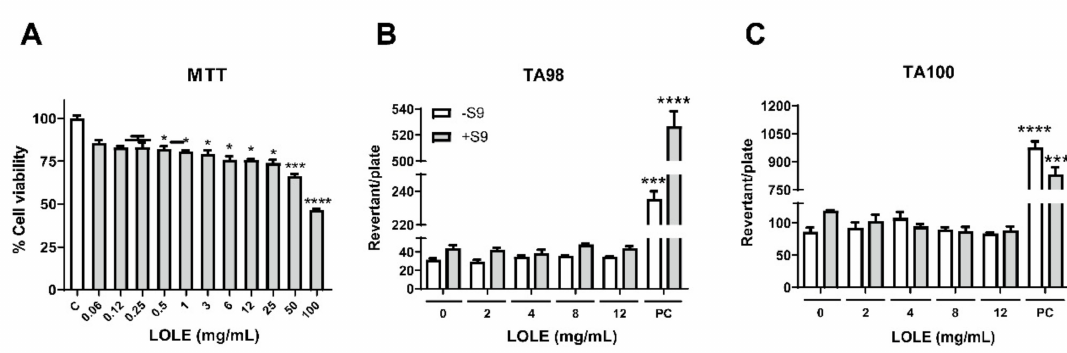
Figure 1. Safety assessment of Lindera obtusiloba leaf extract (LOLE) by cytotoxicity and mutagenicity assays. ( A ) The percentage of cell viability was determined by MTT assay. RAW 264.7 cells were treated with LOLE at various concentrations, and formazan absorbance was measured at 570 nm. The relative cell viability was compared to the control treated with DMSO. ( B , C ) Evaluation of LOLE by Ames test with strains TA98 and TA100, without (S9 + ) and with metabolic activation (S9 + ). The positive controls (PC) employed for (S9 + ) were 4-NQO (4-nitroquinoline 1-oxide, 15 µ g per plate) and for (S9 + ), 2-AA (2-aminoanthracene, 5 µ g per plate), respectively. Phosphate-bu ff ered saline (PBS)-treated samples were used as negative controls for the test without metabolic activation. The white bars represent the control groups, whereas the gray bars represent the intervention groups. Results are expressed as the percentage of neutralized virus compared to control (mean ± SEM; n = 3). **** p < 0.0001 *** p < 0.001, * p < 0.05 vs. negative